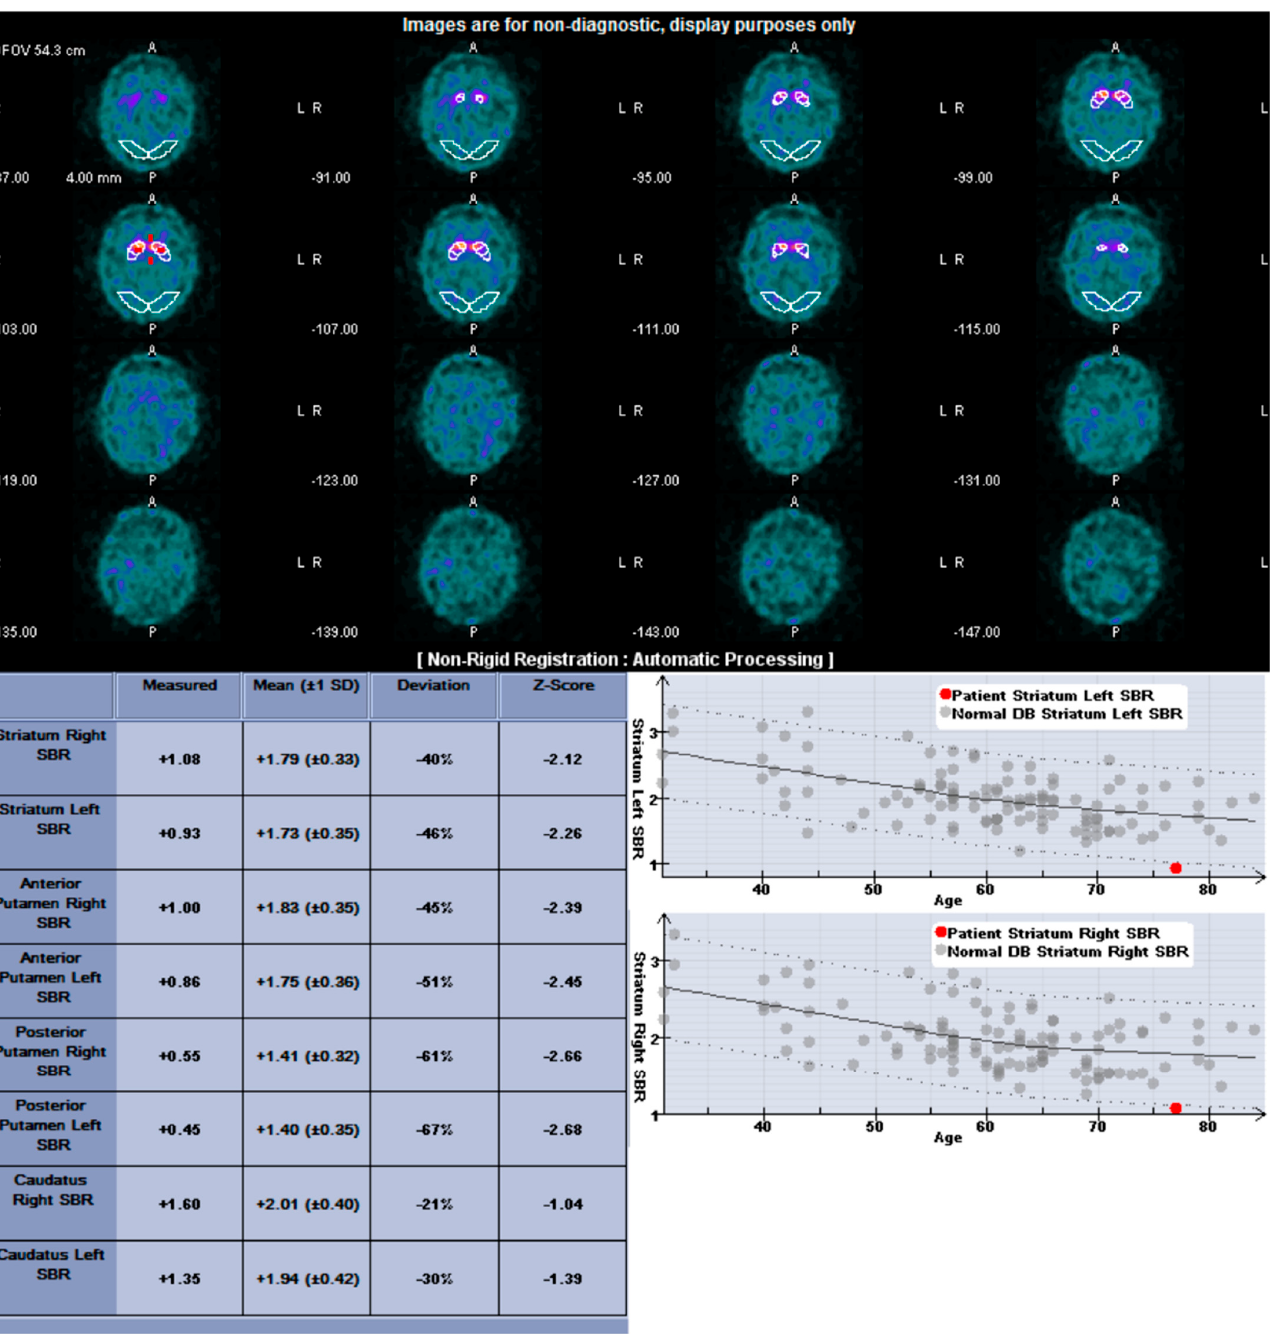
Figure 3. DaTQUANT output for patient 16, as an example. ( Top ): SPECT images with region of interest (ROI) over the striata and background ROIs over occipital region. ( Bottom left ): Table of quantitative parameters. ( Bottom right ): Graph of quantitative measures compared to a population of normal subjects. The red dot denotes the patient’s striatal value, which is abnormally decreased (solid line represents the average for normal subjects and dashed lines represent 2 standard deviations for normal subjects).